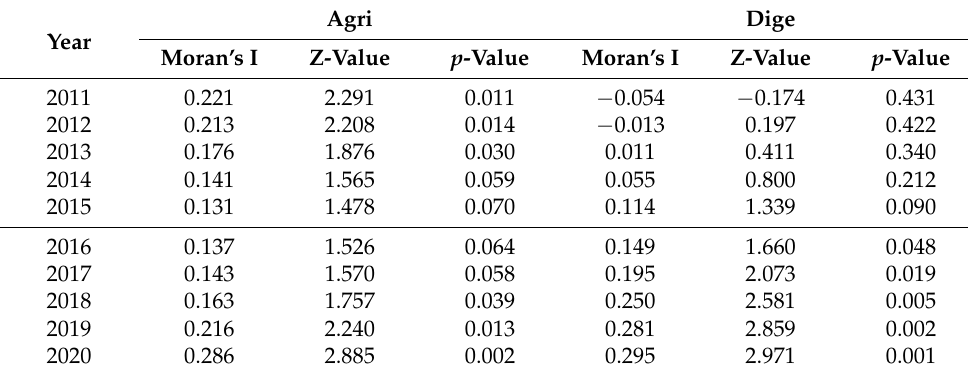
Table 7. Moran’s I of the digital economy and agricultural green development under a geographical weight matrix.